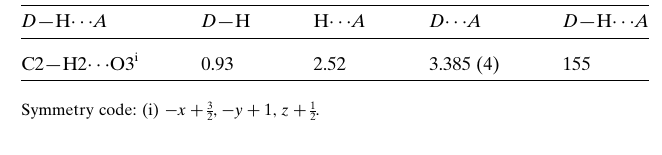
Table 2 Experimental details.